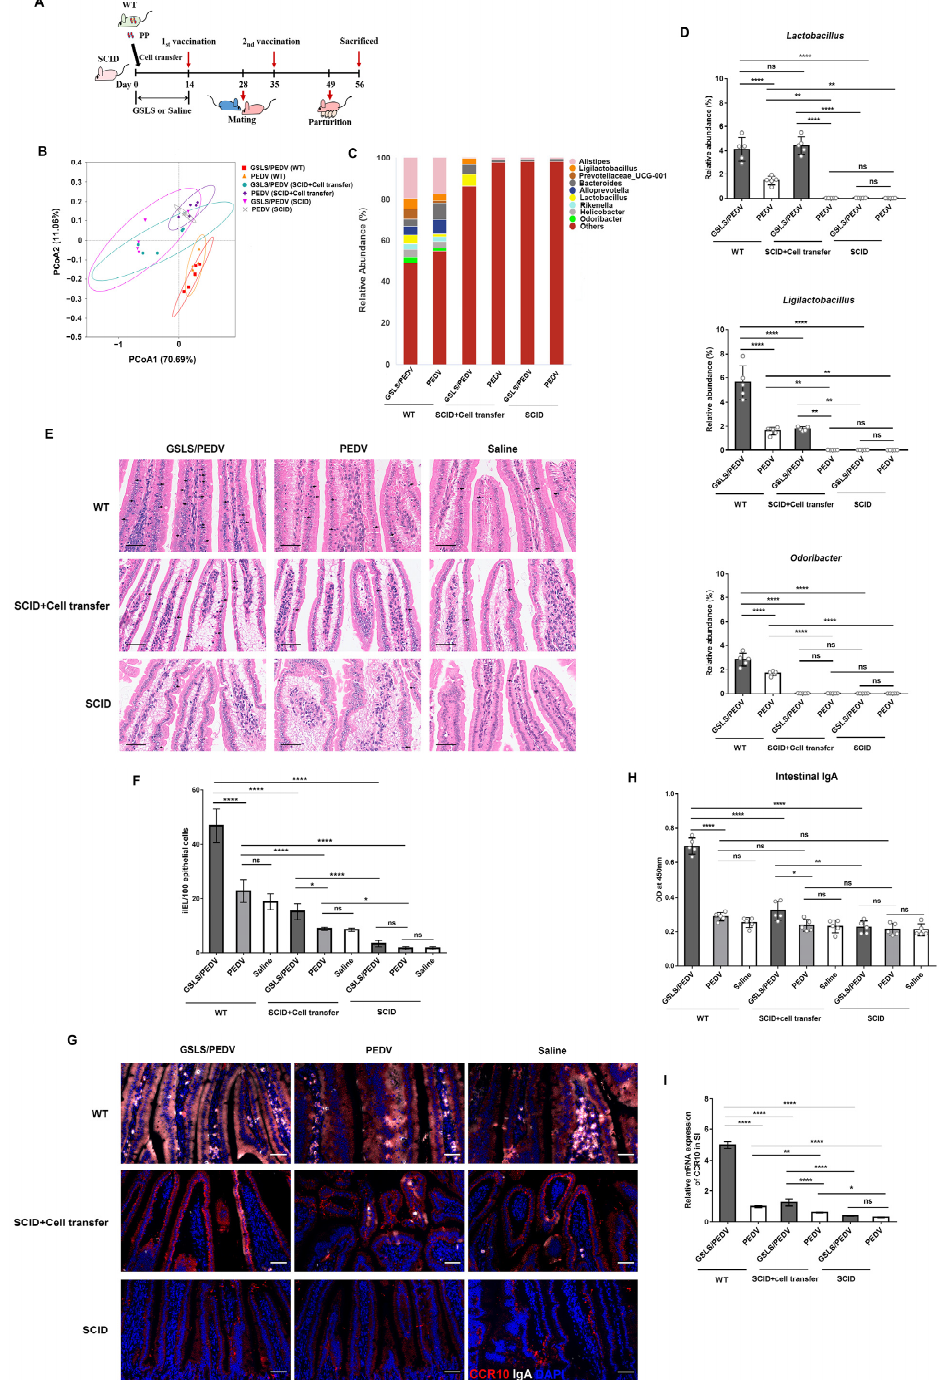
Figure 6. Immunodeficient mice transplanted with PP cells re-establish the intestinal microbiota and regain intestinal immunity after GSLS treatment. Female wild-type (C.B-17/ICR-+/+Jcl, WT)